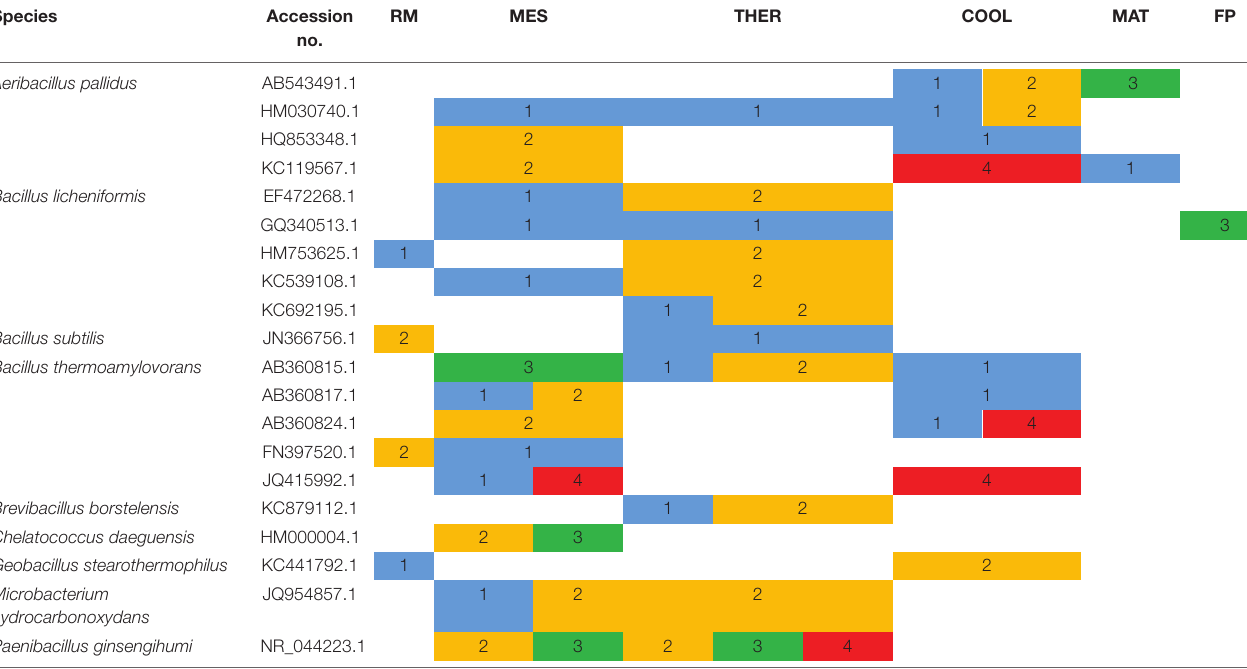
TABLE 2 | Thermal phenotypes of thermophilic xylanolytic bacterial strains with the same accession number detected at the different composting stages: RM, raw material; MES, mesophilic; THER, thermophilic; COOL, cooling; FP, final composting product. Species Accession RM MES THER no.